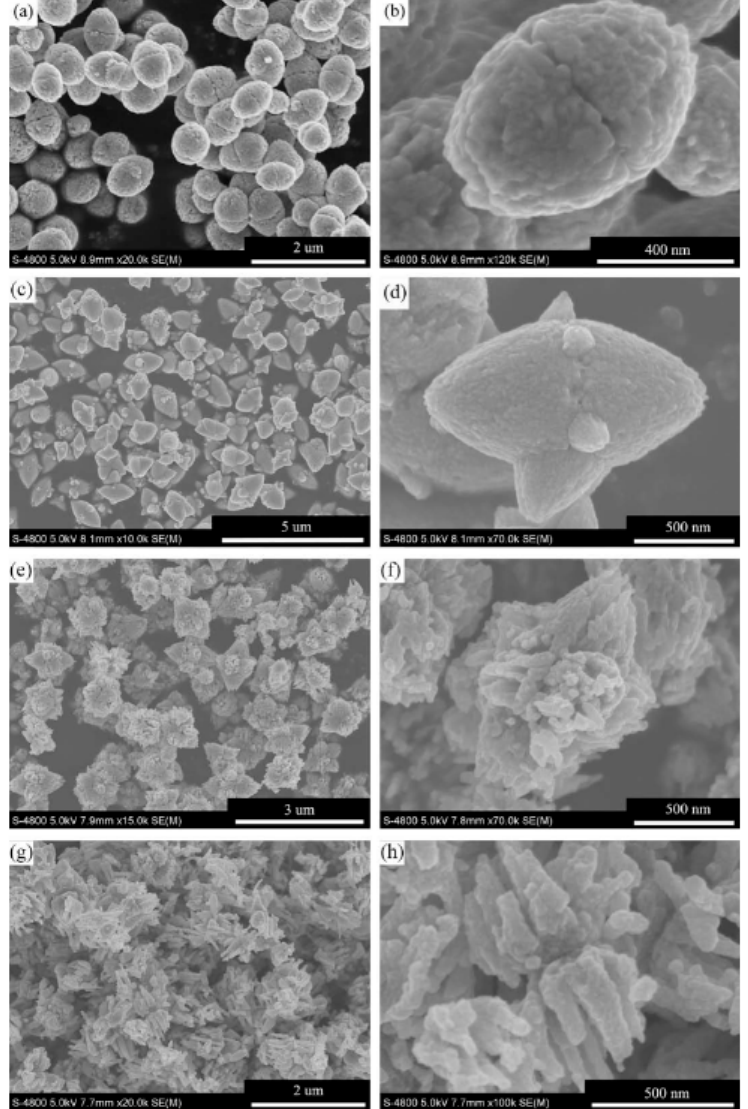
Figure 16. SEM micrographs of ZnO synthesized at pH values of 6 ( a , b ), 8 ( c , d ), 10 ( e , f ), and 12 ( g , h ). Reprinted with permission from [65]. Copyright (2010) Elsevier B.V.